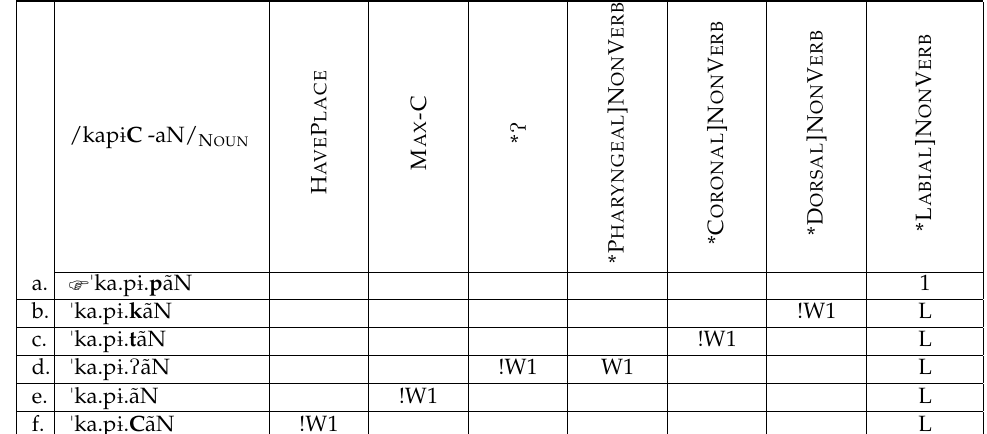
Table 4. /kap ɨ C -aN/ → [ ˈ ka.p ɨ . p ãN] ‘alligator’ (/N/form)—Capanahua. Table 4. /kap 1 C -aN/ → [ " ka.p 1 . p ã N] ‘alligator’ (/N/form)—Capanahua.